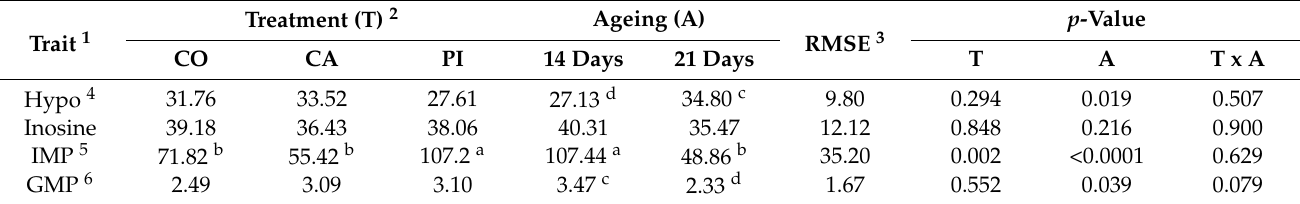
Table 2. Effect of starch source of concentrate and ageing period on ribonucleotide of fattening dairy steers. Trait